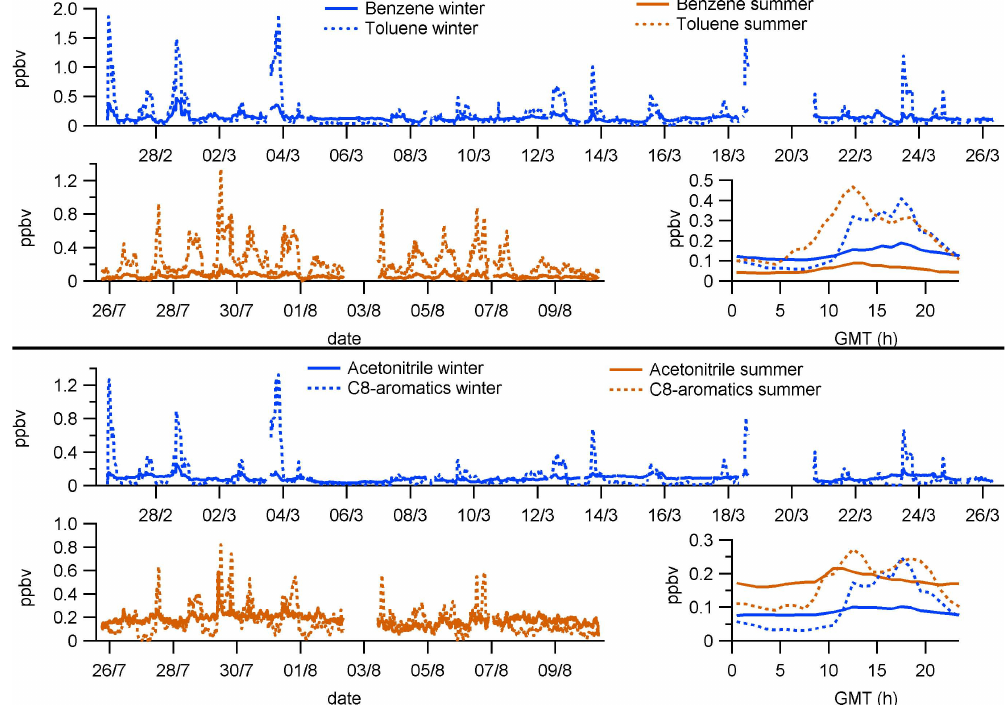
Fig. 7. Aromatic VOCs and acetonitrile measured at MSY, showing their mixing ratios during the winter period (upper graph of each panel), their mixing ratios during the summer period (lower left graph) and their mean daily cycles (hourly averages) for both periods (lower right graph). Note the different scaling for the seasonal trend graphs. Date labels indicate 00:00